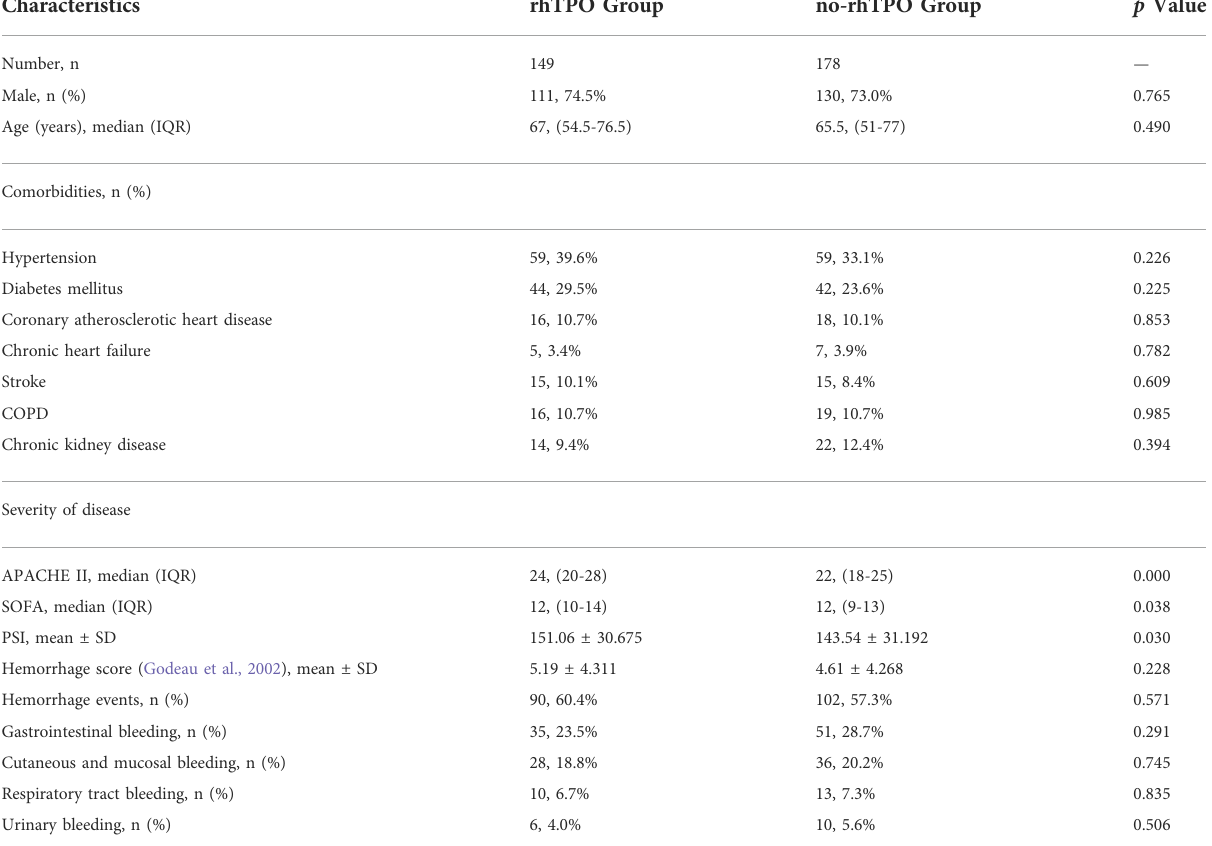
TABLE 1 Demographics and baseline characteristics of